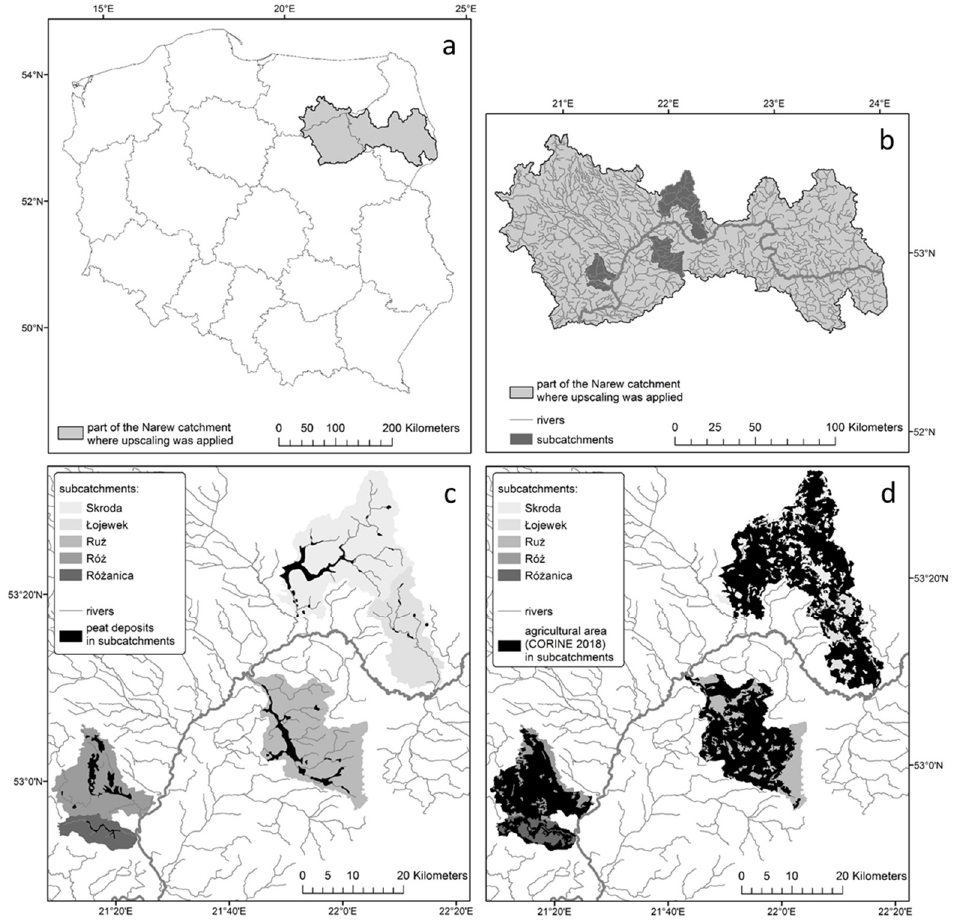
Figure 1. Location of study area: ( a ) part of the Narew catchment where upscaling was applied in relation to the territory of Poland (please note that the whole catchment of Biebrza was excluded from the analyses); ( b ) studied sub-catchments in the Narew catchment; ( c ) peat deposits in sub-catchments [35]; ( d ) agricultural area in sub-catchments [36].